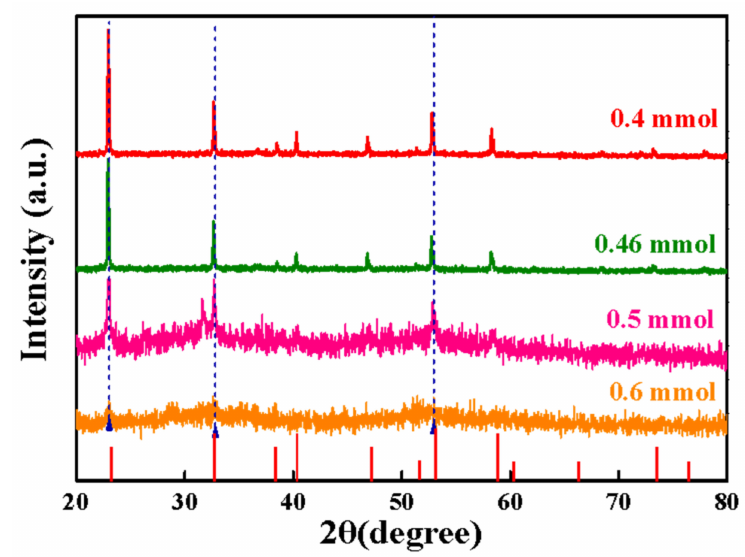
Figure 1. XRD of Co 3 Sn 2 S x samples with different stoichiometric ratios of S elements.